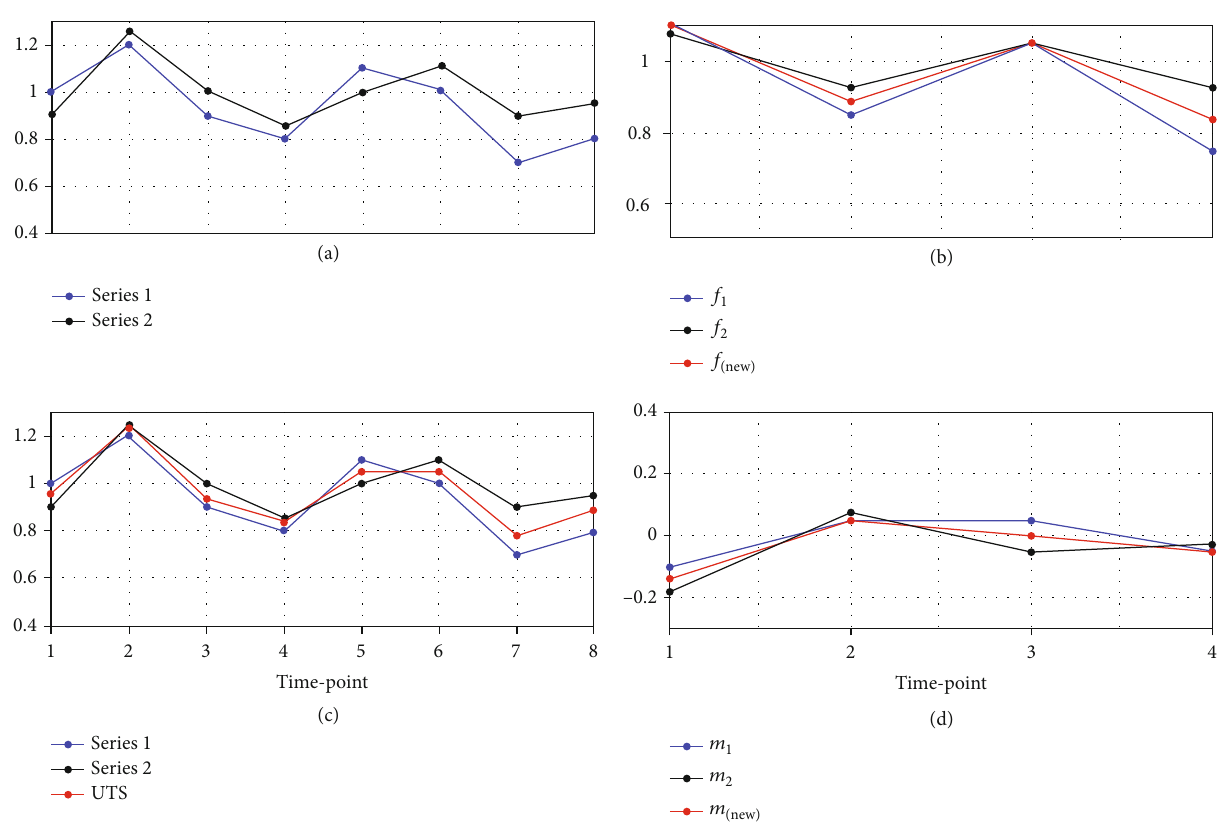
— father wavelets of series 1 and series and f 1 2 — new mother ð new Þ